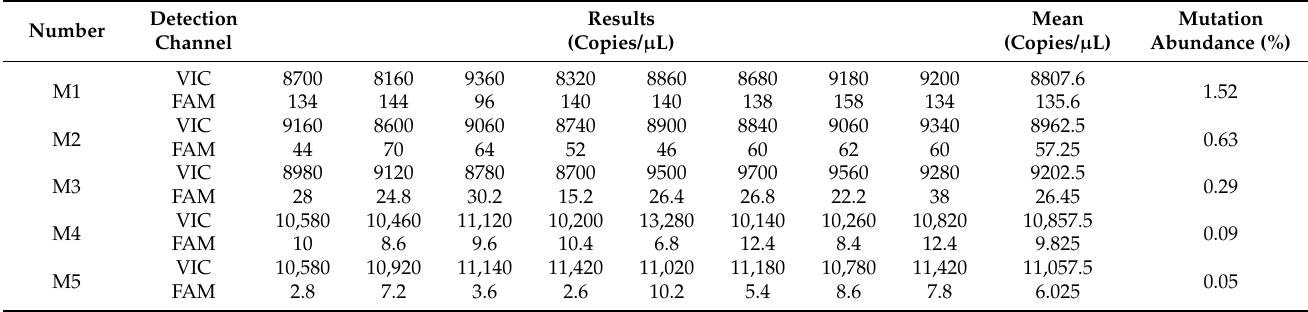
Table 3. dd PCR detection limit of the R294K mutation in WT and MT